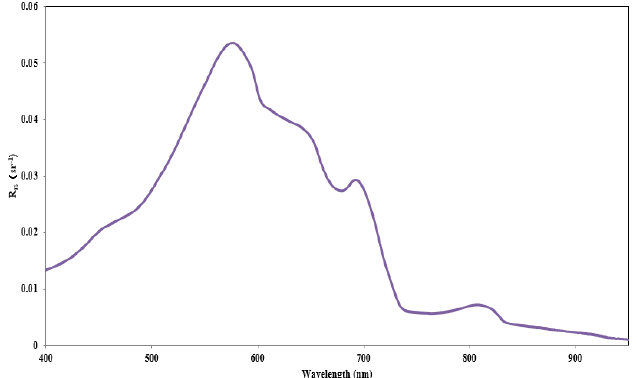
Figure 9. RGB synthetic image, field photo, and remote-sensing reflectance of general water bodies and water colour anomalies in the Xiong’an New Area.